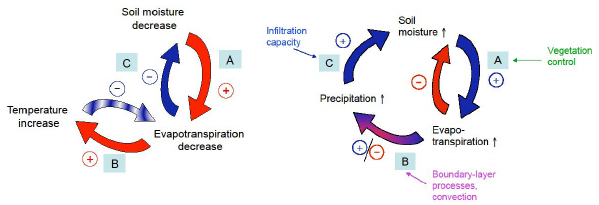
Fig. 6. Processes contributing to soil moisture–temperature coupling and feedback loop (Seneviratne et al., 2010) Relationship (B) relates to the link between evapotranspiration and sensible heat flux. Decreased evapotranspiration leads to an increase in sensible heat flux and thus to an increase in air temperature. Relationship (C) relates to a potential positive feedback leading to a further temperature increase: Increased temperature leads to a higher evaporative demand, and thus to a potential increase in evapotranspiration despite the dry conditions, possibly leading to a further decrease in soil moisture. The feedback loop inducing land-atmosphere coupling can continue until the total drying of the soil, when temperature increases cannot be dampened by any further increases in evapotranspiration. (Seneviratne et al., 2010). In 2011, the pre- conditions for record breaking temperature in summer were met after an intense spring drought, but several waves of heavy rainfall in June may have inhibited the trigger of feedbacks (Quesada et al., 2012). In 2003, spring drought was again intense with precipitation between February and May being below 50%. But this time, the spring drought gave way to consecutive episodes of intensive anticyclonic anomalies in the summer months associated with stationary blocking, clear skies, high temperatures and high evaporation amplifying temperatures through the feedback processes described above (Garcia Herrera et al., 2010). Sensitivity analyses suggest that given climatologic mean soil moisture and similar continental-scale circulation, the 2003 JJA surface temperature anomalies would have been